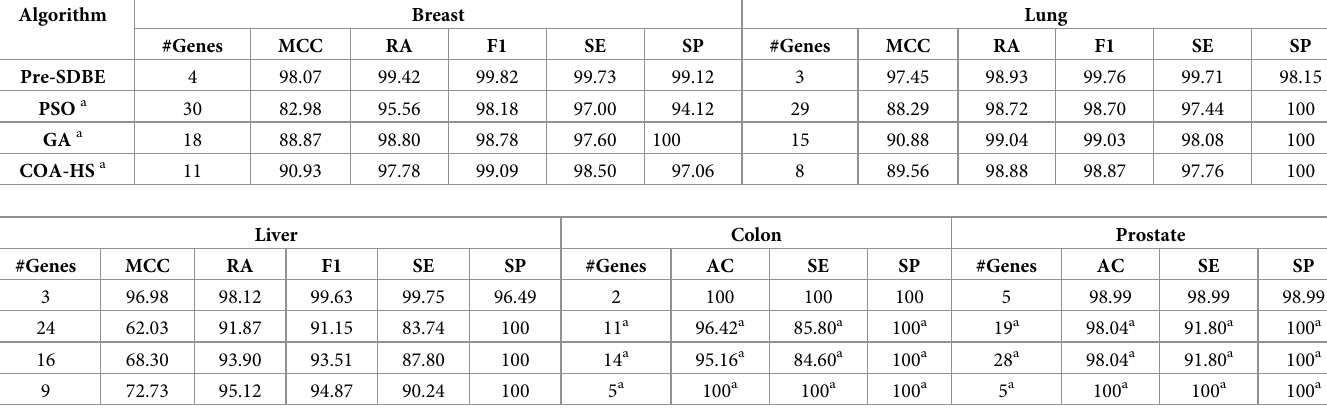
Table 6. Classification metrics (%) of four optimization algorithms for five cancer datasets.